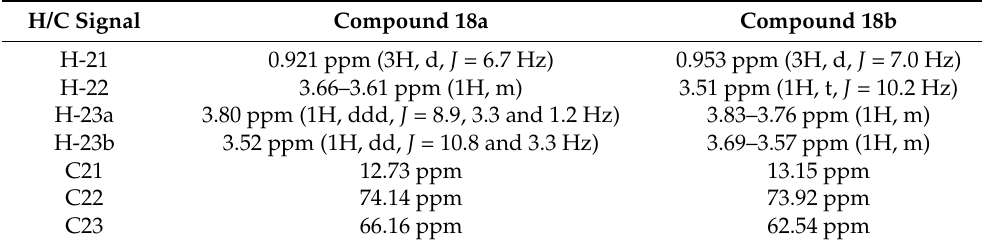
Table 2. Comparison between signals of 1 H- (500.1 MHz, CDCl 3 ) and 13 C- (125.8 MHz, CDCl 3 ) NMR for H/C21, H/C22, and H/C23a-b, for the epimers 18a and 18b .